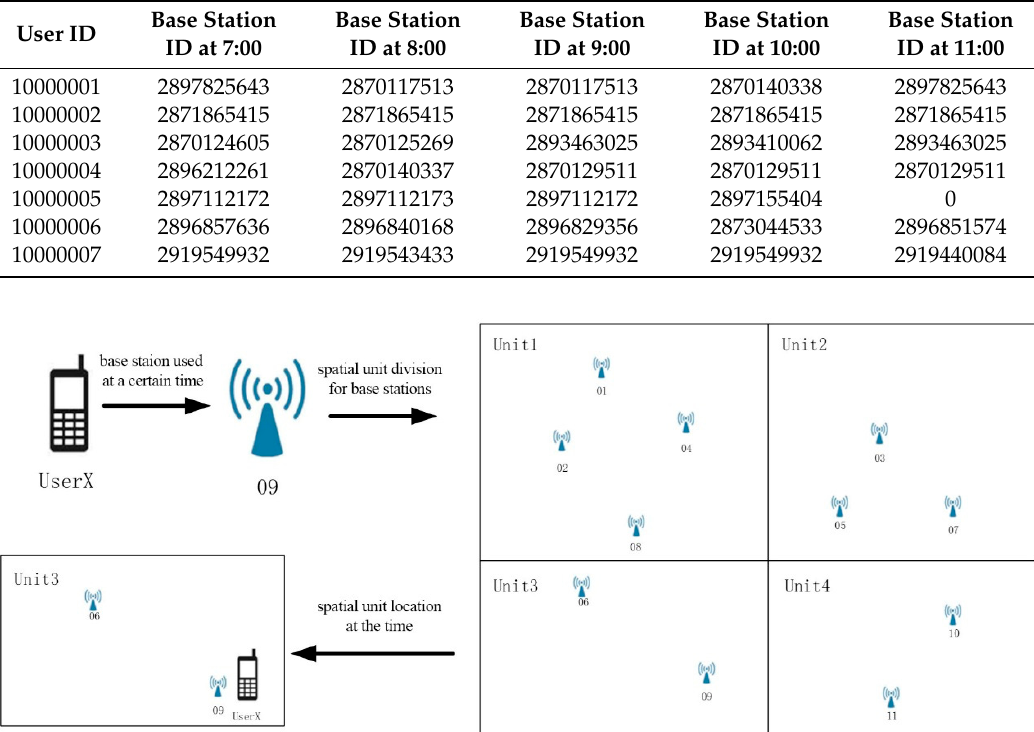
Table 2. Sample statistics of base stations assigned to user ID at different hours of a day.